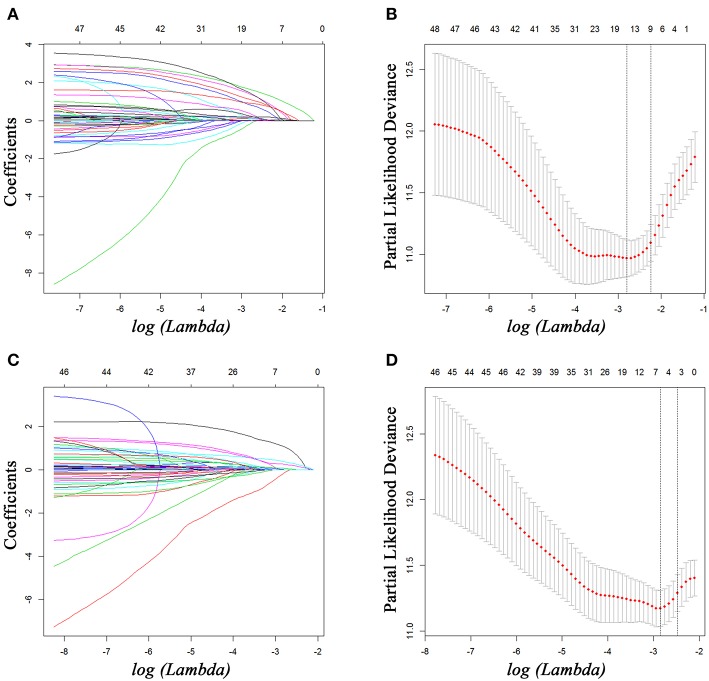
Feature selection using the least absolute shrinkage and selection operator (LASSO) Cox regression model. LASSO coefficient profiles of 48 variables against the log (Lambda) sequence for PFS (A) and tuning parameter (Lambda) selection in the LASSO model used 10-fold cross-validation via minimum criteria for PFS (B). LASSO coefficient profiles of 48 variables against the log (Lambda) sequence for OS (C) and tuning parameter (Lambda) selection in the LASSO model used 10-fold cross-validation via minimum criteria for OS (D). PFS, progression-free survival; OS, overall survival.